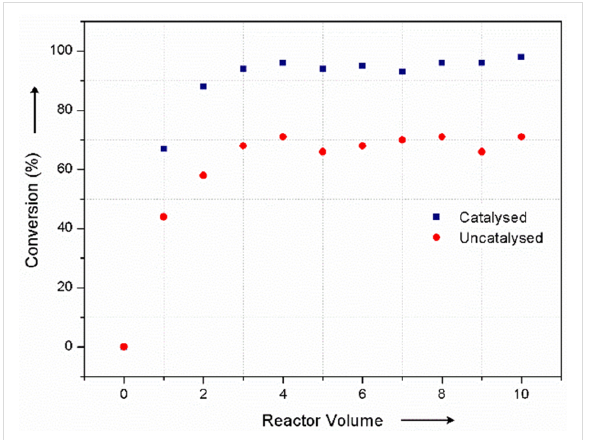
Figure 3: Continuous-flow amide 18 formation using 1-stage CSTR. Blue squares: FeCl 3 included; red circles: FeCl 3 not